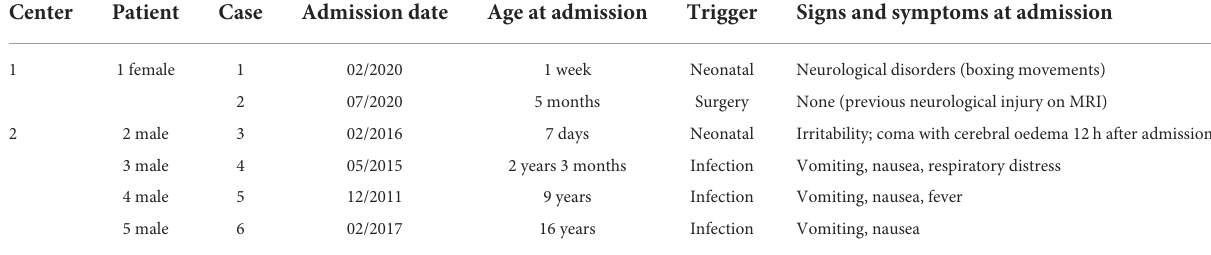
TABLE 1 Patient characteristics at